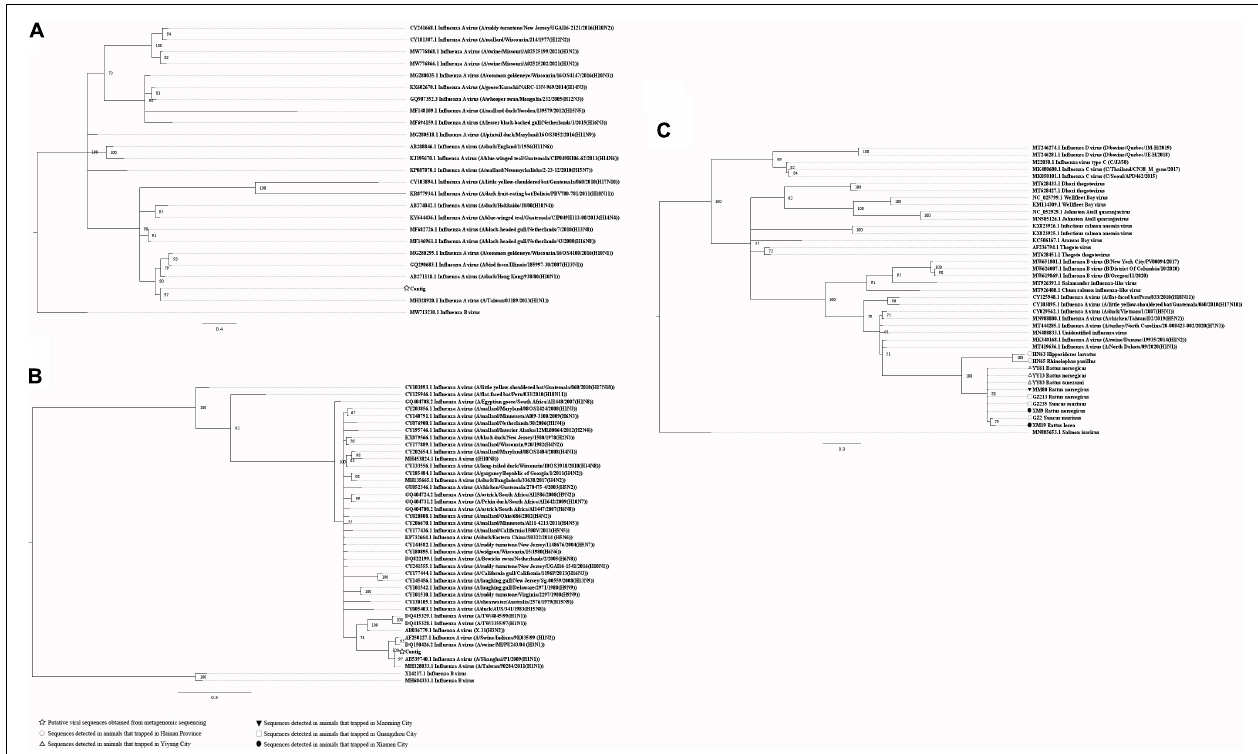
FIGURE 5 | (A) Phylogenetic tree constructed based on potential viral nucleotide sequence (148 bp, neuraminidase gene) related to influenza A virus that obtained by using metagenomic sequencing (MrBayes, GTR + G + I nucleotide substitution model). A total of 23 representative sequences belonging to different species within genus Alphainfluenzavirus are included for comparison, one sequence belonging to genus Betainfluenzavirus is set as outgroup. Percentages of the posterior probability (PP) values are indicated. (B) Phylogenetic tree constructed based on potential viral nucleotide sequence (150 bp, nucleocapsid protein gene) related to influenza A virus that obtained by using metagenomic sequencing (MrBayes, GTR + G + I nucleotide substitution model). A total of 39 representative sequences belonging to different species within genus Alphainfluenzavirus are included for comparison, two sequences belonging to genus Betainfluenzavirus are set as outgroup. Percentages of the posterior probability (PP) values are indicated. (C) Phylogenetic tree constructed based on PCR-screened nucleotide sequences (156 bp) of influenza A virus from urban rats, bats, and house shrews (MrBayes, GTR + G + I nucleotide substitution model). A total of 30 representative sequences (matrix region) belonging to different genera within family Orthomyxoviridae are included for comparison. One sequence of salmon isavirus is set as outgroup. Percentages of the posterior probability (PP) values are